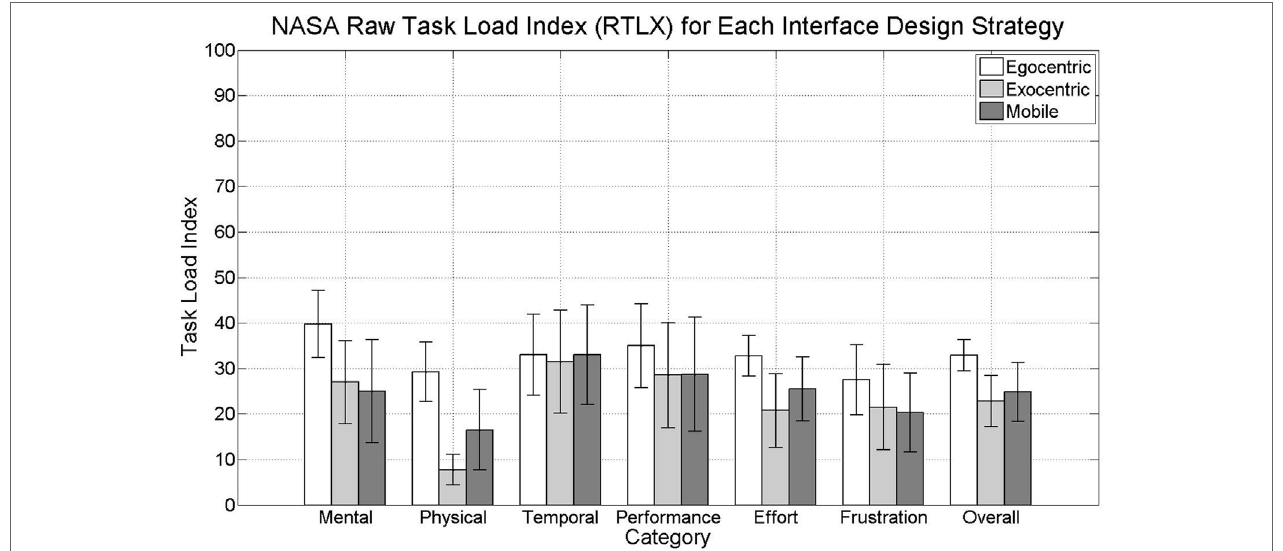
FigUre 13 | Workload reported by participants for each category, as well as the computed overall index